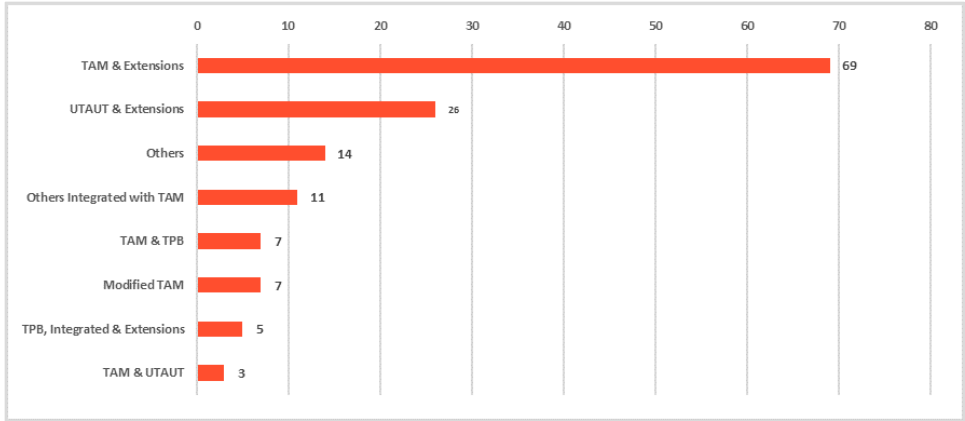
Figure 2. Most studied technology acceptance